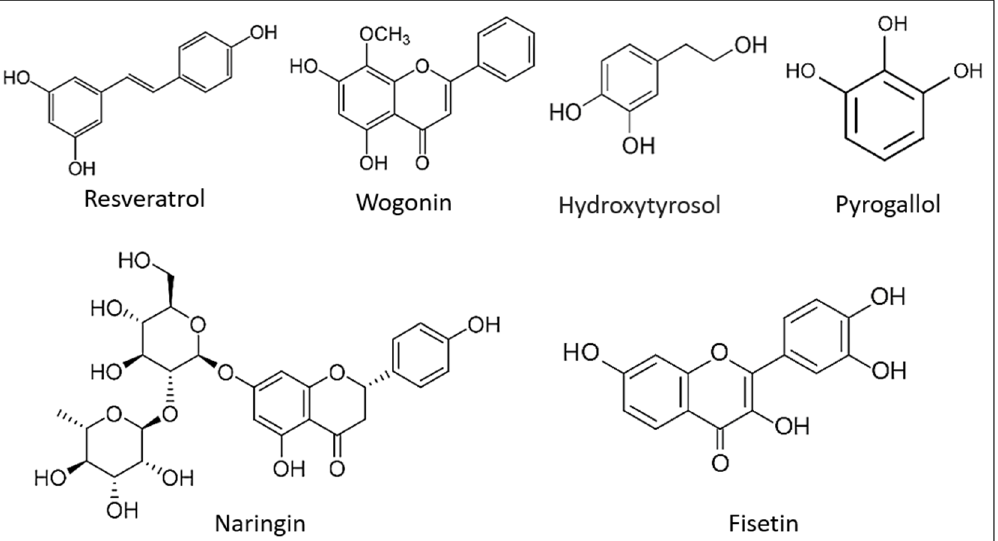
Figure 4. Chemical structure of some polyphenolic compounds with anti-eryptotic activity.